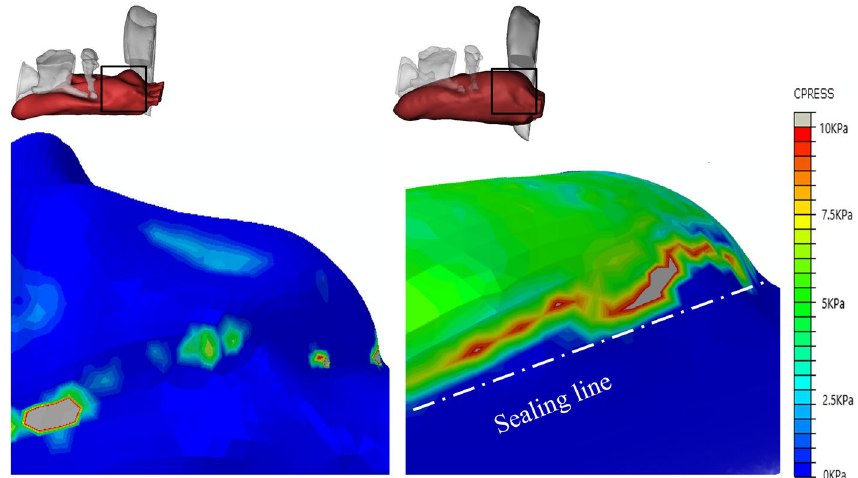
Figure 9. The pressure on oropharyngeal mucosa of PB-LMA50 (left) and PB-LMA100 (right) (lateral view). The pressure of most oropharyngeal mucosa is almost 0 kPa in PB-LMA50; the white dash-dotted line in left image means a line sealing pressure is developed when the cuff pressure increased to recommended